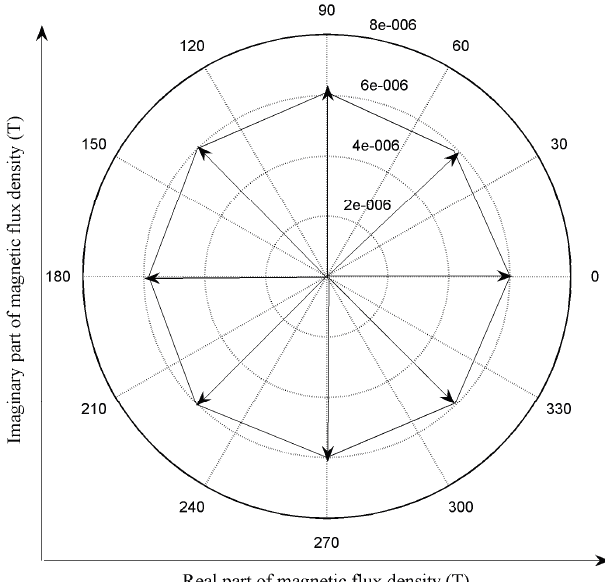
Figure 4. Changes of magnetic flux density